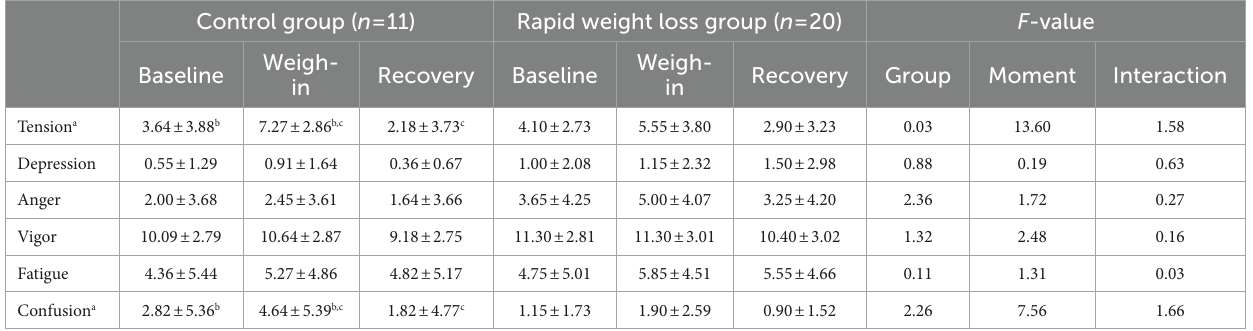
TABLE 2 Mood states of combat sports athletes submitted or not to weight loss to compete.